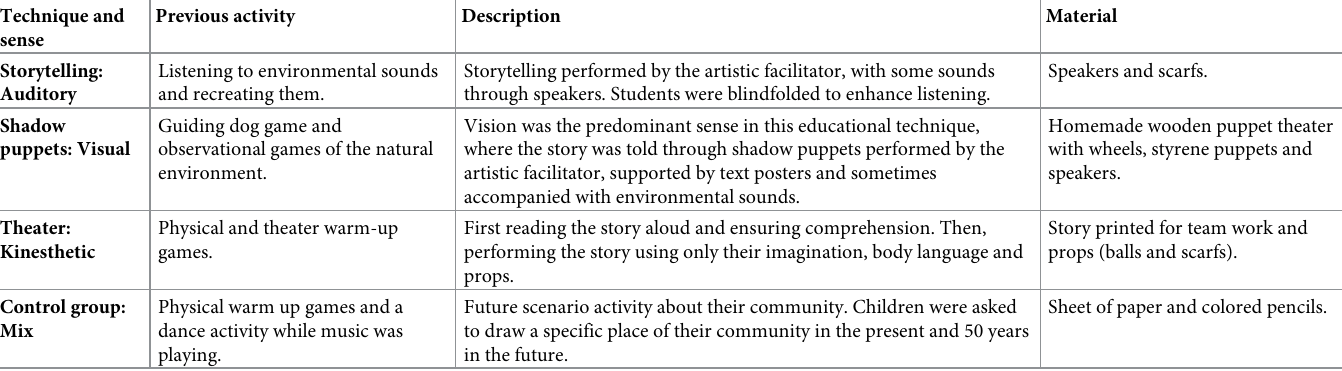
Table 1. Description of all the arts-based educational techniques used, including previous activities and materials used. Technique and Previous sense